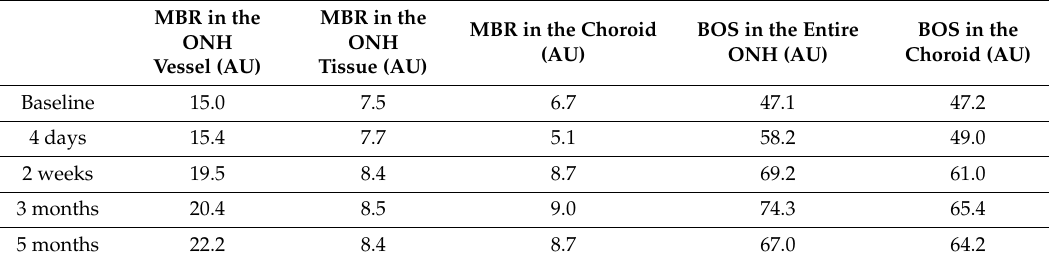
Table 1. Time course of mean blur rate and blowout score in the optic nerve head and choroid in the left eye. MBR; mean blur rate, AU; arbitrary units, ONH; optic nerve head, BOS; blowout score. MBR in the MBR in the MBR in the Choroid BOS in the Entire BOS in the ONH ONH (AU) ONH (AU) Choroid (AU) Vessel (AU) Tissue (AU) Baseline 15.0 7.5 6.7 47.1